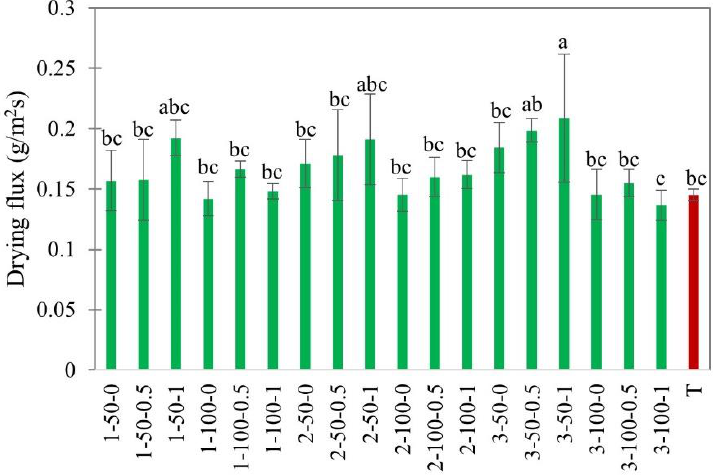
Figure 4. Drying flux of EHD (marked in green and labeled as thickness-slice load density-airflow) and hot air-dried (marked in red as T) apple slices. Different lower-case letters indicate statistically significant differences ( p < 0.05).